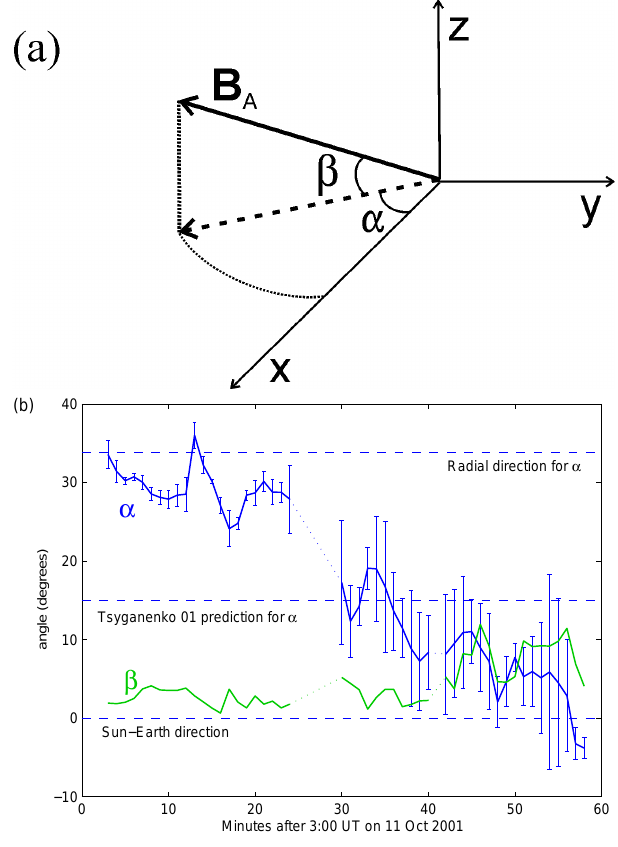
Fig. 4. The orientation of the ambient magnetic field at the Cluster site. (a) Definition of the angles α and β . The axes represent the GSM coordinate system. (b) The orientation of the ambient mag- netic field as a function of time, obtained from minimum/maximum variance analysis. The lines are the averages of the results from the four spacecraft and the error bars show their standard devia- tion. Those data points where the standard deviation exceeds 20 ◦ are